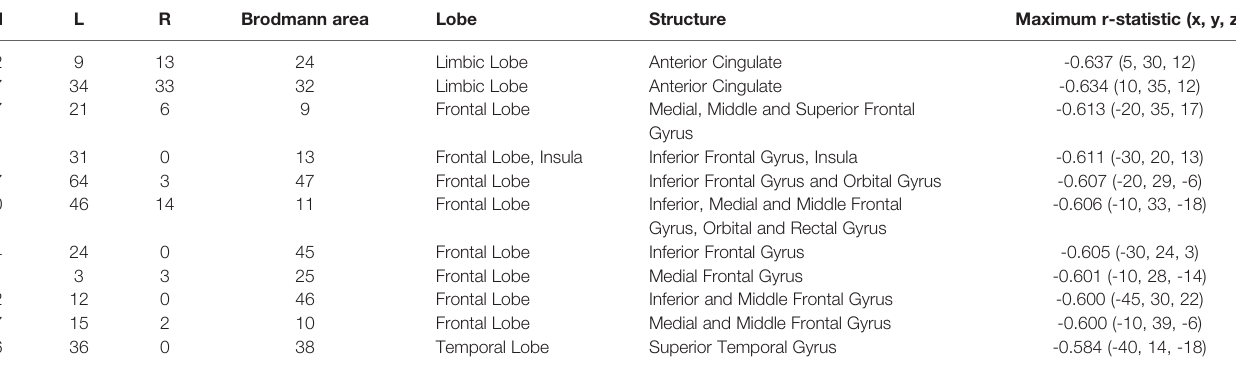
Negative r-values indicate inverse correlation between the 4-week change of MADRS score and the baseline exact low-resolution brain electromagnetic tomography (eLORETA) current density values in the alpha-2 frequency band (10.5 – 12 Hz) for the whole sample group (N = 25). The number of all signi fi cant voxels (and separately for the left and right hemispheres) are given for each affected Brodmann area of brain regions. L, left; R, right; x, y, z = Talairach